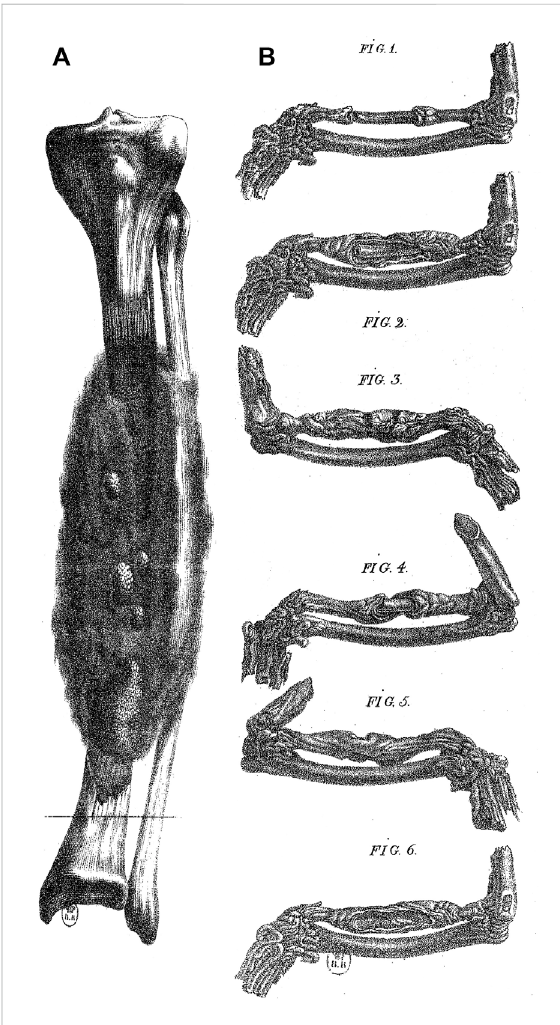
FIGURE 1 Bone regeneration in man and in the pigeon. (A) A case of bone regeneration in man (tibia). Adapted from plates 1 and 2, Charmeil, 1821. (B) Experiment by Charmeil of the destruction of the periosteum and endosteum in a portion of a bone from the pigeon wing. The destruction of the periosteum and endosteum induced necrosis followed by regeneration (Fig. 1). (Fig. 2 to Fig. 6), different stages of regeneration. Adapted from Charmeil, 1821.